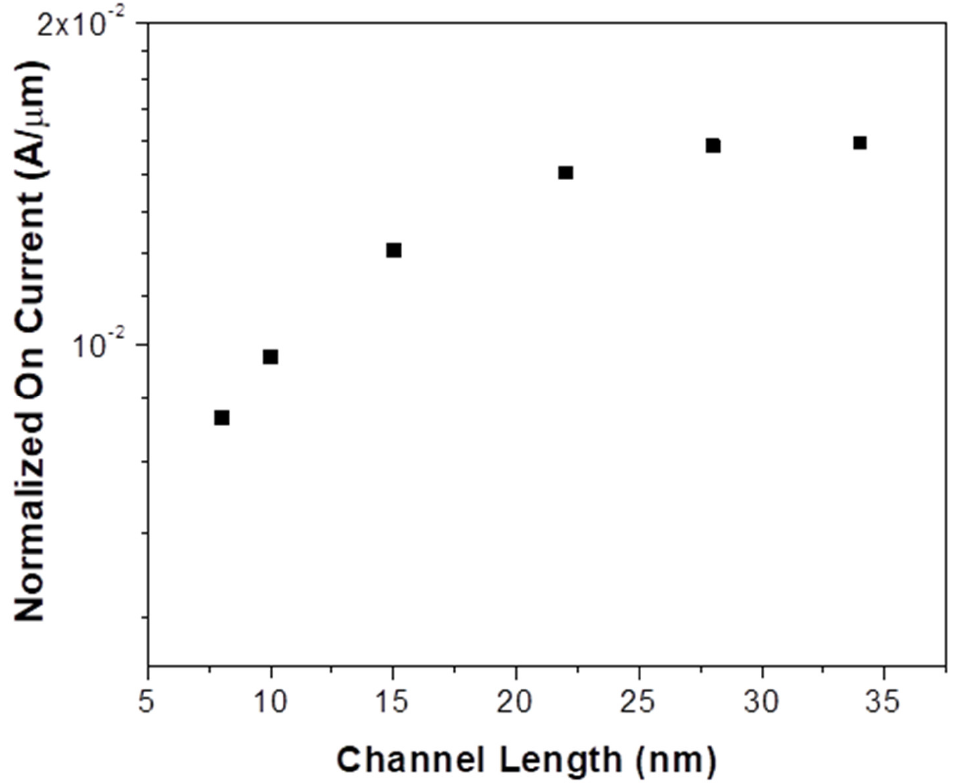
Figure 7. Normalized On-current (in A/µm) vs. channel length (in nm). This plot suggests that the on-current is independent of channel length and is determined by the tunneling path and velocity saturation.